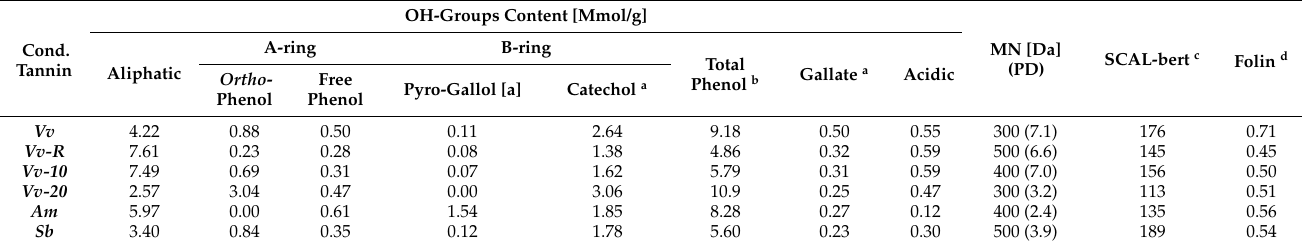
Table 2. Results of quantitative 31 P NMR analyses of phosphitylated commercially available condensed tannins, number average molecular weights and polydispersities as well as cyanidin contents and total phenolic OH-group content. Errors vary depending on signal overlap (see Supplementary Materials); the average error is 0.5 mmol/g.